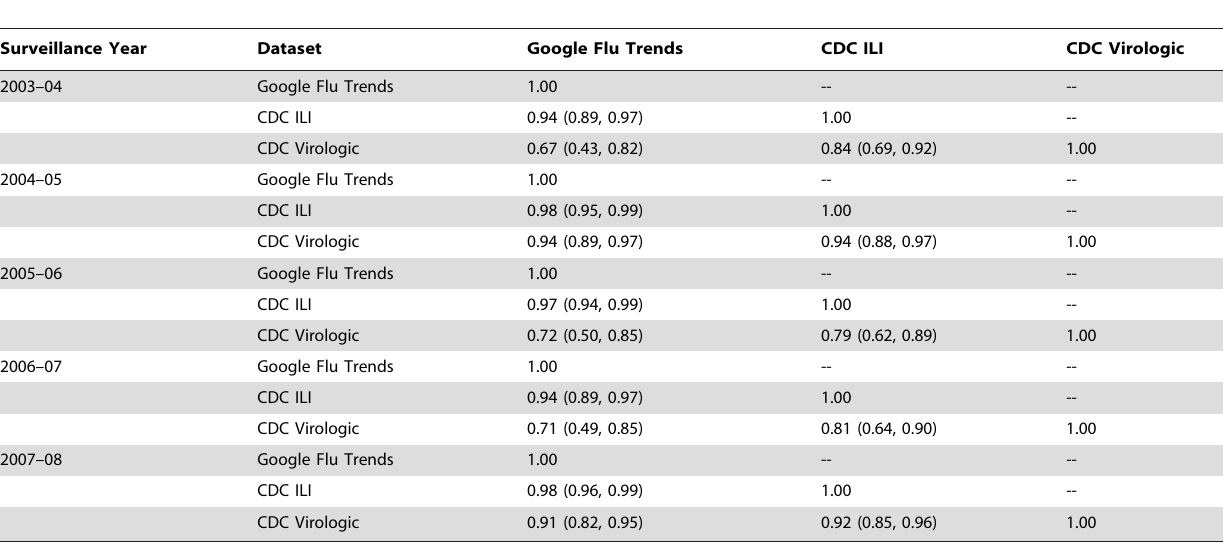
Table 2. Pearson’s Correlation Coefficient Matrix of Data from Three Influenza Surveillance Systems by Surveillance Year: Google